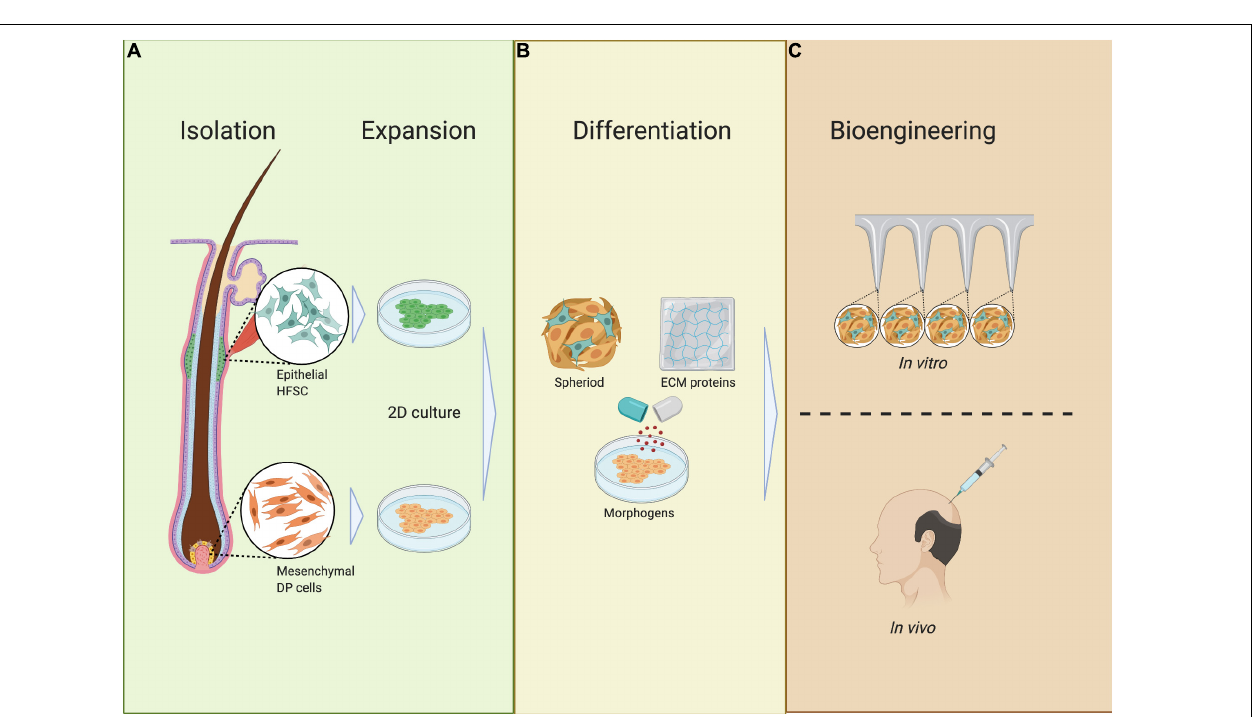
FIGURE 9 | Requirements of bioengineered HF germs. (A) Isolation and expansion; epithelial HF stem cells (HFSCs) and mesenchymal dermal papilla cells (DPCs) are isolated from the HF during the anagen phase, after which HFSCs and DPCs are expanded in 2D culture. (B) Differentiation; HFSCs and DPCs are mixed together with ECM proteins and differentiated into spheres in 3D culture. (C) Bioengineering; HFSC- and DP-containing spheres are placed in an ECM scaffold or full skin equivalent to track HF neogenesis or are transplanted in vivo .